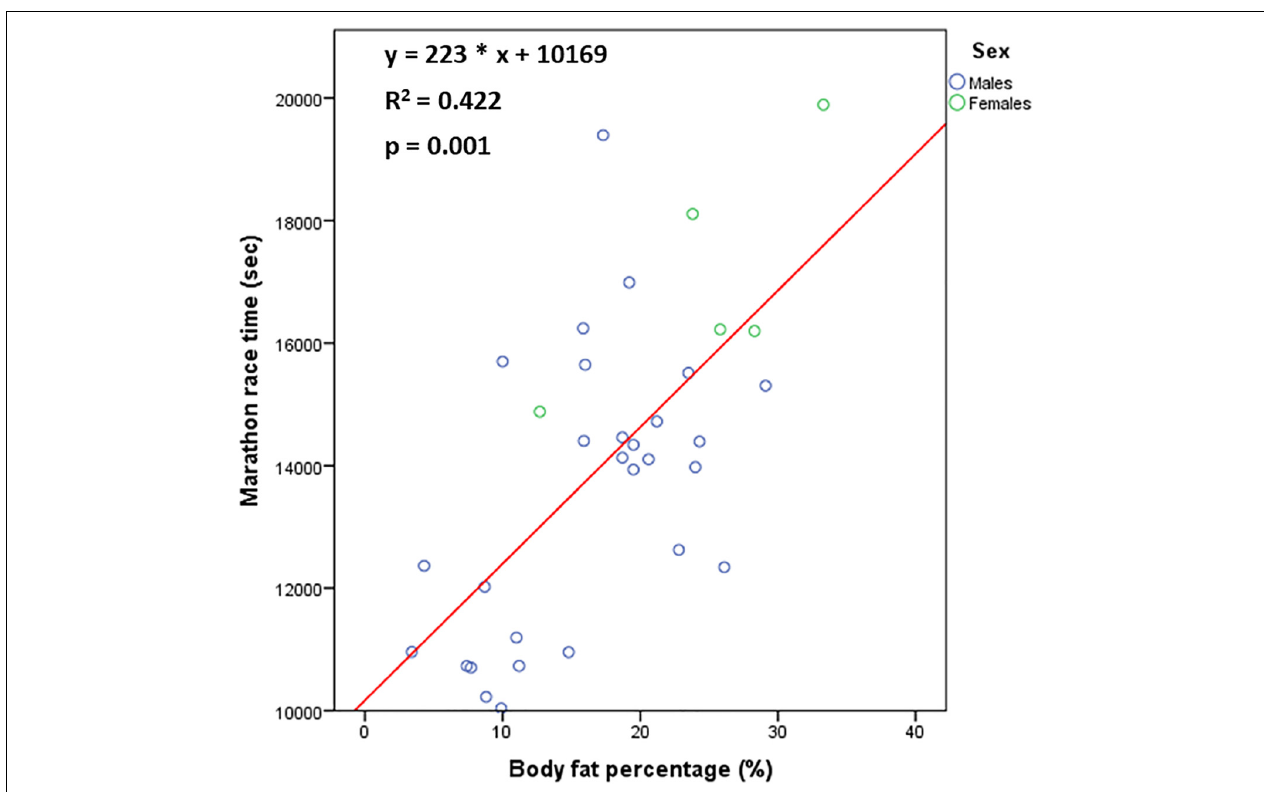
FIGURE 2 | The relationship [ n = 33 (27 males, 6 females)] between marathon race time and body fat percentage.